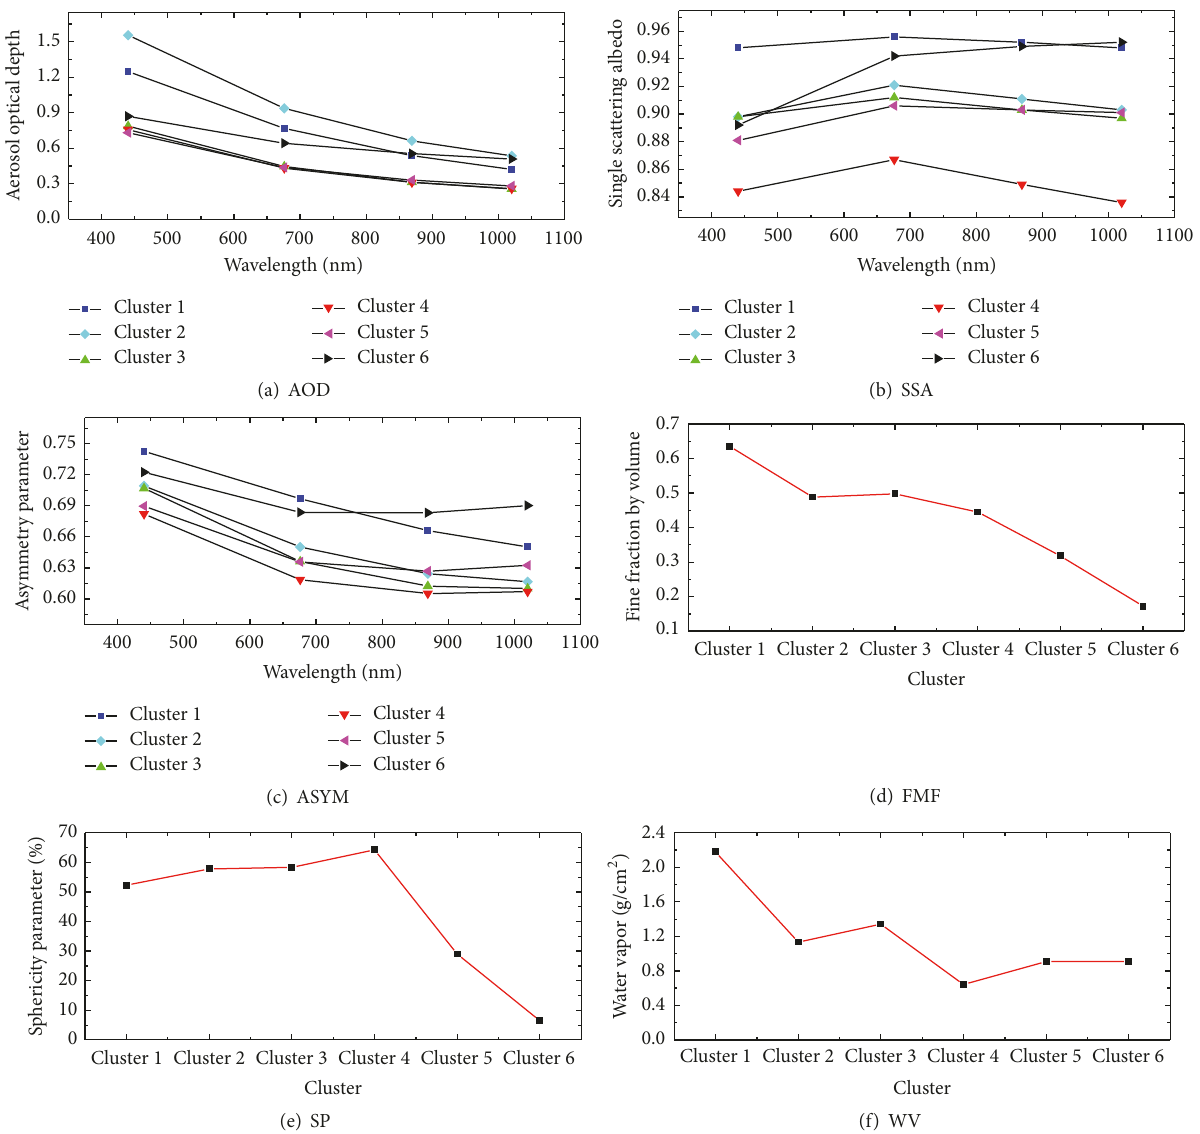
Figure 2: The characteristics of six cluster centers: (a) aerosol optical depth; (b) single scattering albedo; (c) asymmetry parameter; (d) fine fraction by volume; (e) sphericity parameter; (f) water